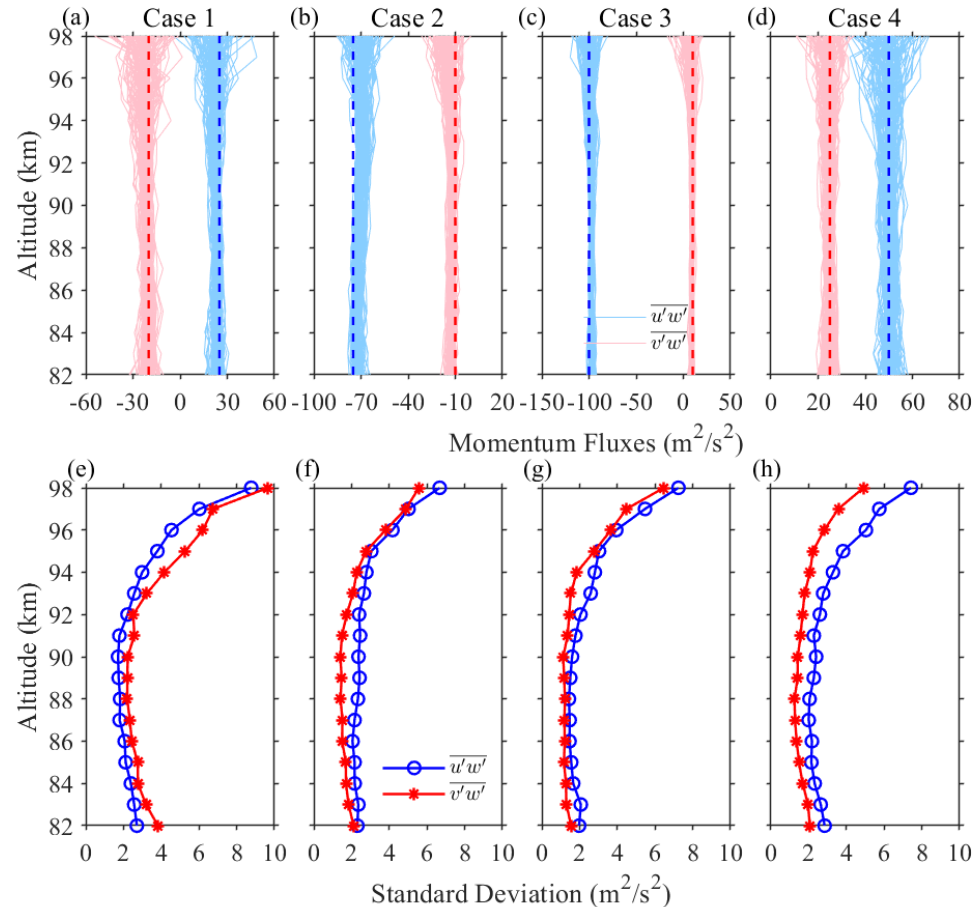
Figure 8. ( a – d ) Estimated zonal (sky-blue lines) and meridional (pink lines) GW momentum fluxes using the MCD method in each month, for the period between 2012 and 2021. The specific mean GW momentum fluxes are plotted in blue (red) dashed lines. ( e – h ) The altitudinal variations in the standard deviation of the vertical fluxes of the zonal and meridional GW momentum are plotted in blue solid-circles and red solid-asterisk lines, respectively. Columns from left to right are for Cases 1 – 4.